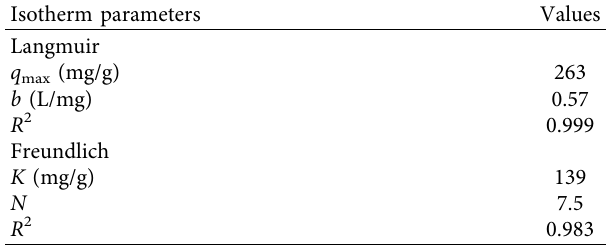
Table 2: Langmuir and Freundlich constant calculated from ad- sorption isotherm data of CV onto Khulays natural bentonite. Isotherm parameters